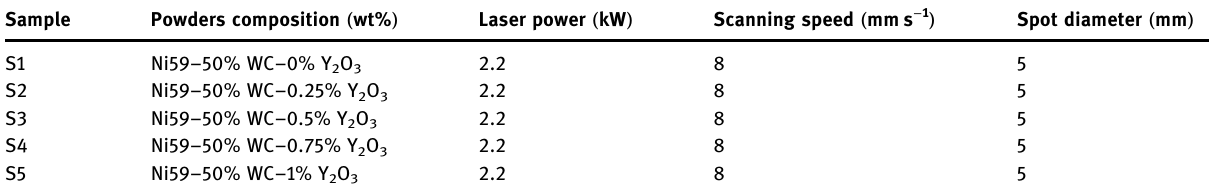
Table 2: Parameters of the process and powder compositions preplaced Sample Powders composition ( wt% )